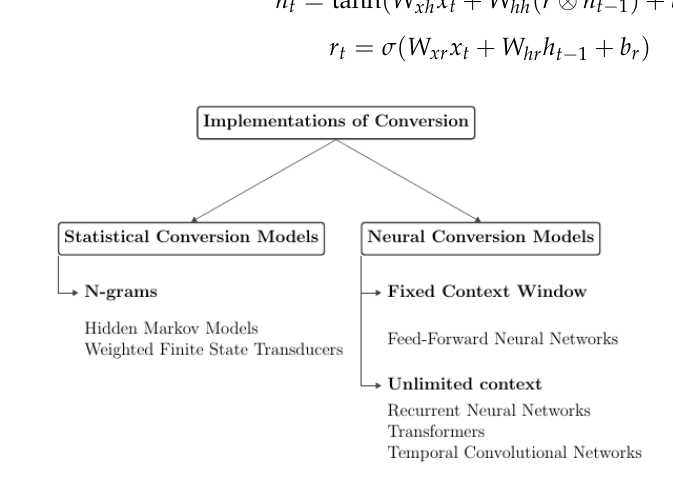
Figure 1. Taxonomy of viseme-to-word conversion models. GRUs are able to select whether a unit for a timestep should have short or long term dependency. Reset gates help to capture short-term dependencies while update gates capture long terms dependencies, and this helps GRUs in ignoring parts of sequences when needed. The reset gate r and update gate u can be switched on and off by containing values close to one and zero, respectively, and Equations (15)–(17) have been derived, indicating how a GRU behaves when the reset and update gate variables approach asymptotic limits. A GRU behaves similarly to a vanilla RNN when both gates are switched on, as indicated by Equation (15). When the update gate is switched off, the hidden state gives more attention to the previous hidden states (Equation (16)), while setting off the reset gate would cause the GRU to give more attention to the current input at that timestep (Equation (17)). With this in mind, a GRU-based language model is better at modelling shorter length dependencies within a sentence for values of r close to zero, which make it less susceptible to the possibility of compound